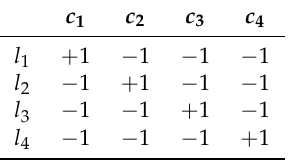
Table 3. Classification coding matrix of the one-versus-all (OVA) scheme. c